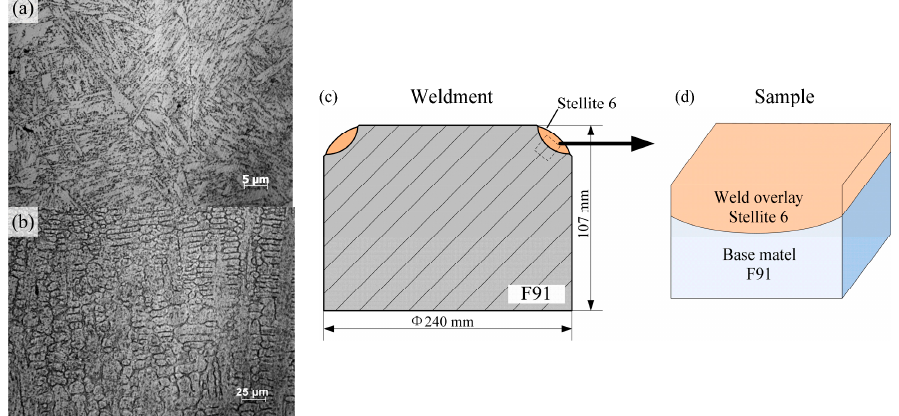
Figure 1. ( a ) Microstructure of F91 steel; ( b ) Microstructure of Stellite 6 alloy; ( c ) The schematic of the overlay weldment of Stellite 6 alloy on F91 steel; ( d ) the sample for microstructural and micro-hardness analysis.